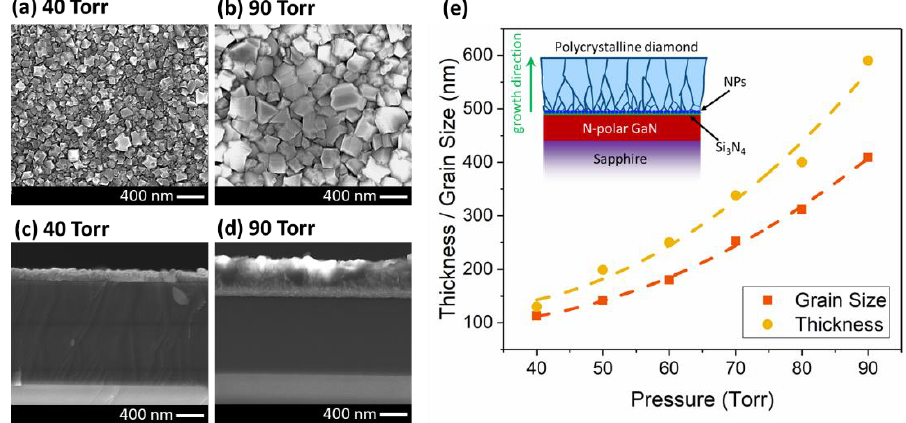
Figure 3. Plan- and cross-sectional-view SEMs of the diamond layer at ( a , c ) 40 and ( b , d ) 90 Torr. ( e ) The relationship between thickness / grain size and the pressure (lines are guides to the eye only). (Inset figure) Schematic cross-section of the sample after diamond growth.